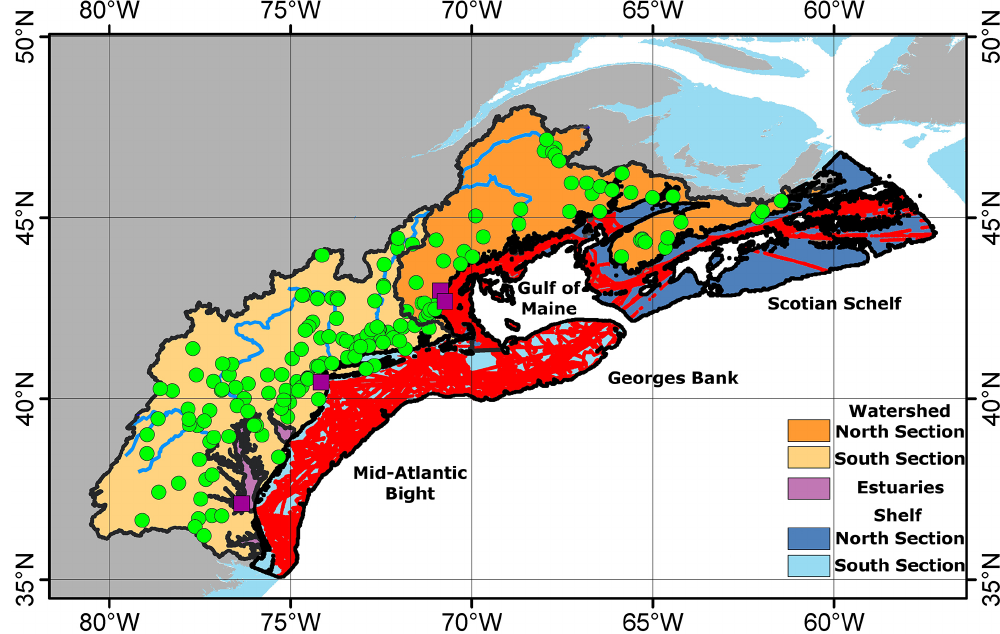
Figure 1. Geographic limits of the study area with the location of the riverine (GLORICH database, in green; Lauerwald et al., 2013) and continental shelf waters data used for our calculations (SOCAT 2.0 database, in red; Bakker et al., 2014). The location of the estuarine studies used is indicated by purple